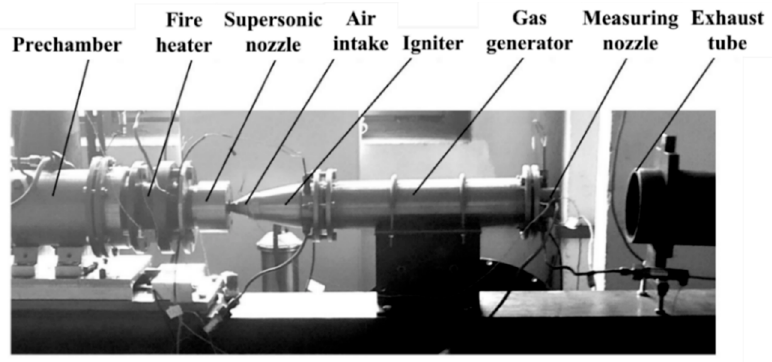
Figure 1. General view of the free jet test facility with GG. Three profiled nozzles with an exit diameter of 30 mm designed for flow Mach num- bers M 0 = 2.5, 3.0 and 4.0 could be attached to the fire heater. Table 1 shows the calculated and measured parameters of the corresponding jet flow. Measurements of the real values of the flow Mach number M 1 were performed using a Pitot pressure sensor (Pitot pressure P 0 (cid:48) ) installed at the nozzle exit. In each experiment, the total pressure P 0 ( t ) and stagnation temperature T 0 ( t ) were recorded for calculating the mass flow rate of gases, G 0 ( t ). A jet of hot gasifying agent from the facility nozzle partly entered the GG mounted downstream along the facility